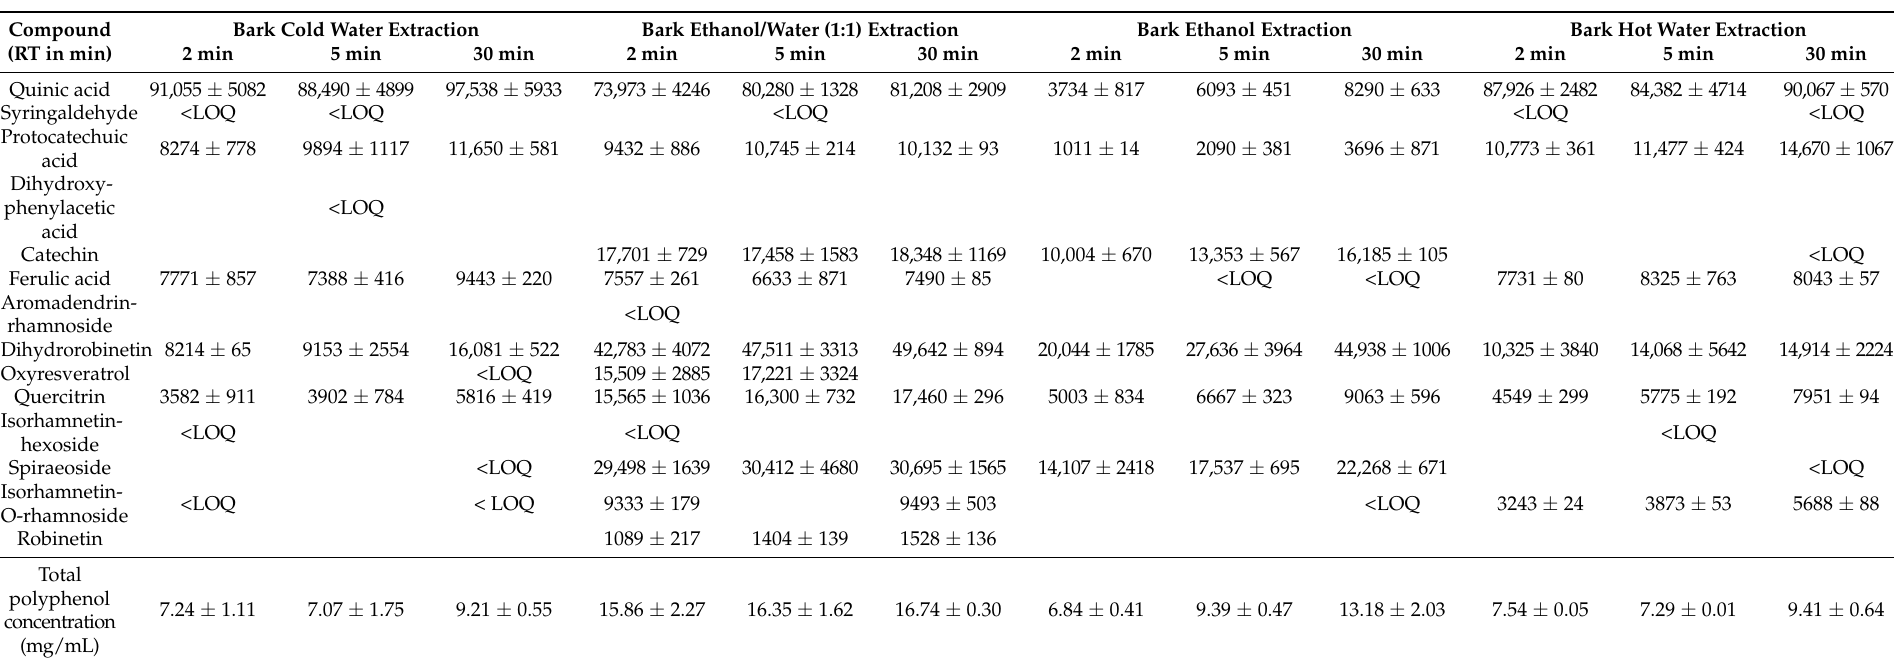
Table 5. Phenolic compounds found in bark extracts, which were obtained by extraction for 2, 5, or 30 min in an ultrasound bath with different solvents (cold water, ethanol, ethanol/water, or hot water). The quantities for each compound are given as peak areas. The total polyphenol concentration is given in